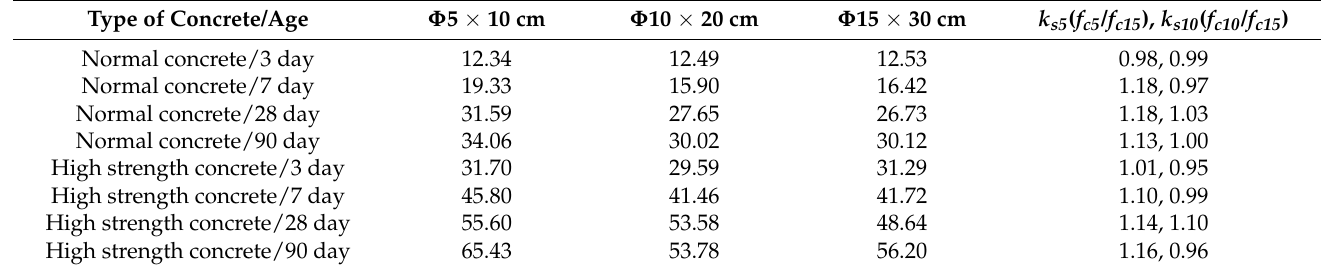
Table 5. Strength and k s value from different size cylinders